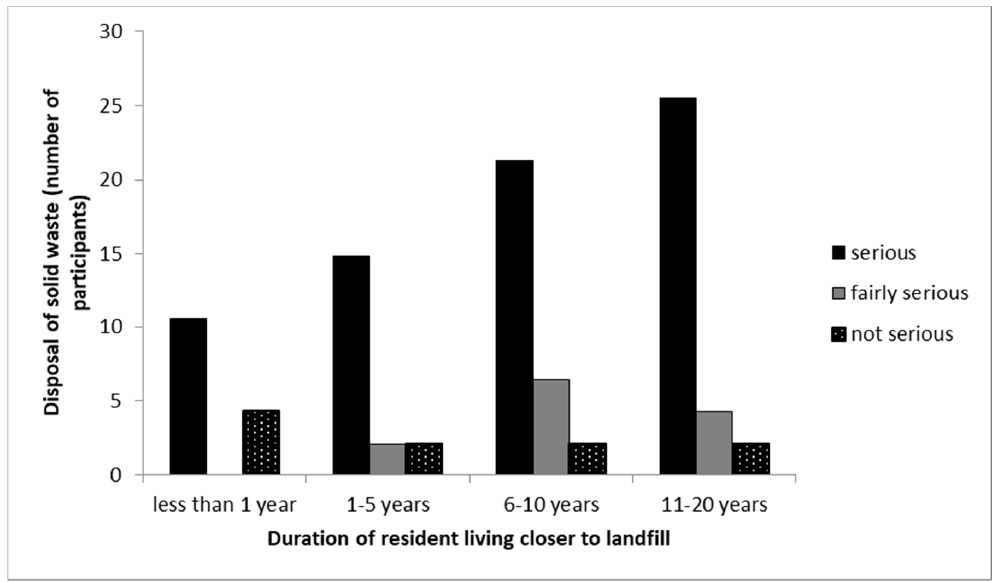
Figure 2. Cross-tabulation between the duration residents that lived in the CL community and the seriousness of solid waste disposal. Note that the no bar section in the figure indicates there was no response by the participant.